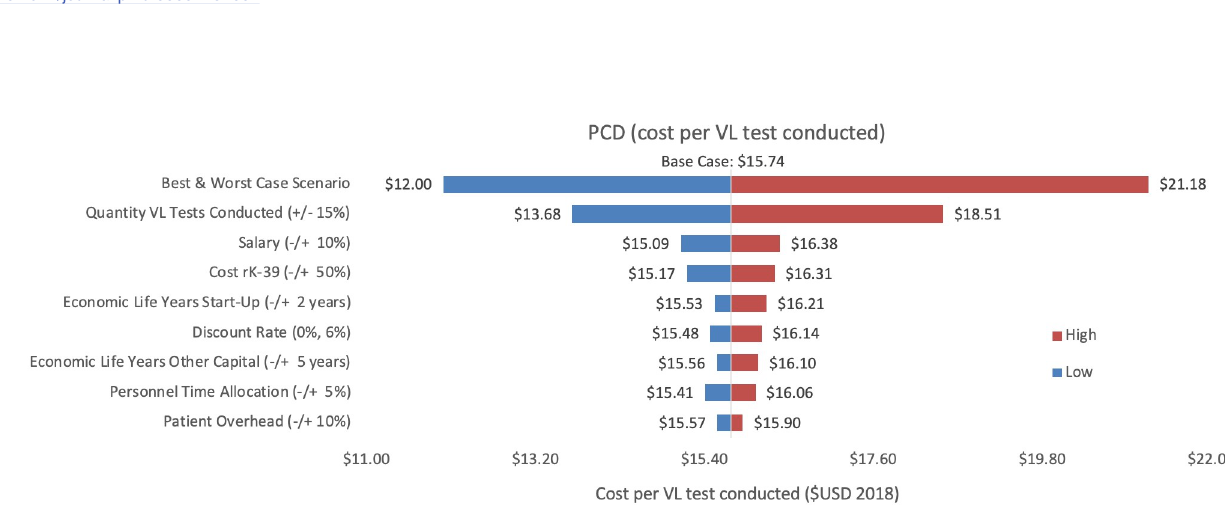
Fig 2. Sensitivity analysis of PCD costs per VL test conducted. Variations in PCD cost per VL test conducted in Bihar during 2018.